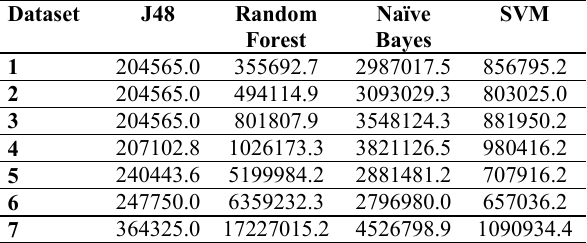
Table 9. Model size (Java Serialized Objects) of each algorithm and